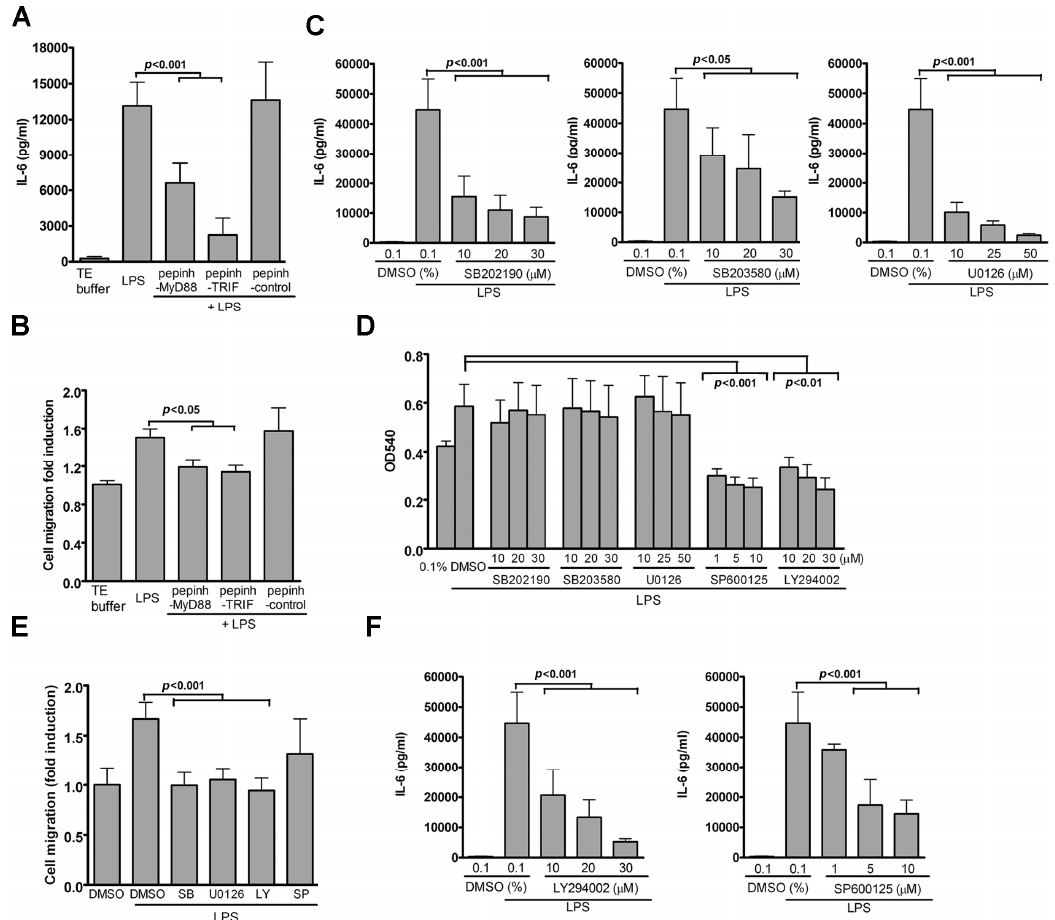
Figure 4. TLR4-mediated IL-6 production and VSMC migration depend on p38 MAPK and ERK1/2 pathway-mediated by Myd88 or TRIF. VSMCs were pretreated with pepinh-MyD88 (Myd88 signaling inhibitor) or pepinh-TRIF (TRIF signaling inhibitor) for 30 min, then stimulated with LPS for 24 h. ( A ) IL-6 levels in culture supernatants were measured by ELISA. p < 0.001 vs. LPS; ( B ) VSMC migration was measured by the transwell assays. p < 0.05 vs. LPS; ( C – F ) VSMCs were pretreated with various concentrations of the indicated inhibitors (SB202190 or SB203580 for p38; U0126 for ERK1/2; SP600125 for JNK; or LY294002 for PI3K) for 30 min and then stimulated with LPS for 24 h; ( C ) IL-6 levels in culture supernatants were measured by ELISA. p < 0.001 or 0.05 vs. LPS; ( D ) MTT assay was used to determine cell viability. p < 0.001 vs. LPS with SP600125; p < 0.01 vs. LPS with LY294002; ( E ) VSMC migration was measured by the transwell assays; ( F ) IL-6 levels in culture supernatants were measured by ELISA. p < 0.001 vs. LPS + dimethyl sulfoxide (DMSO). Data in A – F represent mean ± SD of three experiments. Statistical analyses were performed using the one-way ANOVA.